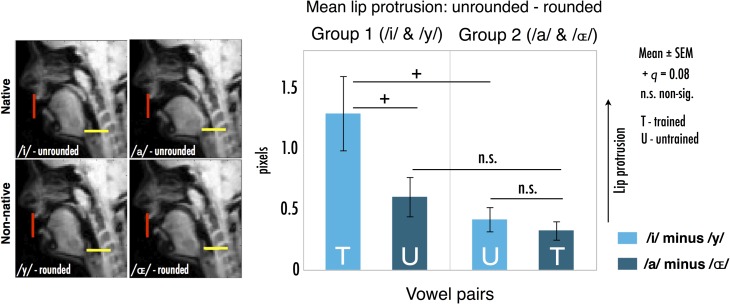
Left: Example lip (red) position traces as measured from rtMRI images in a single subject. Right: Lip protrusion difference metrics per group (unrounded – rounded lip × co-ordinate). Positive values indicate relatively greater protrusion for the rounded than unrounded vowel; note that all means are significantly greater than 0 (all P < 0.005; see Results). See Results for description of statistical interaction.